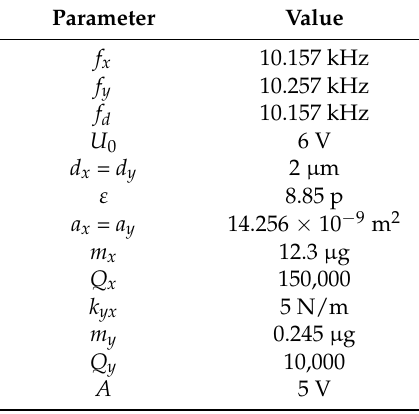
Table 1. Micro-gyroscopes PSPICE model simulation parameters ( T = 27 ◦ C).